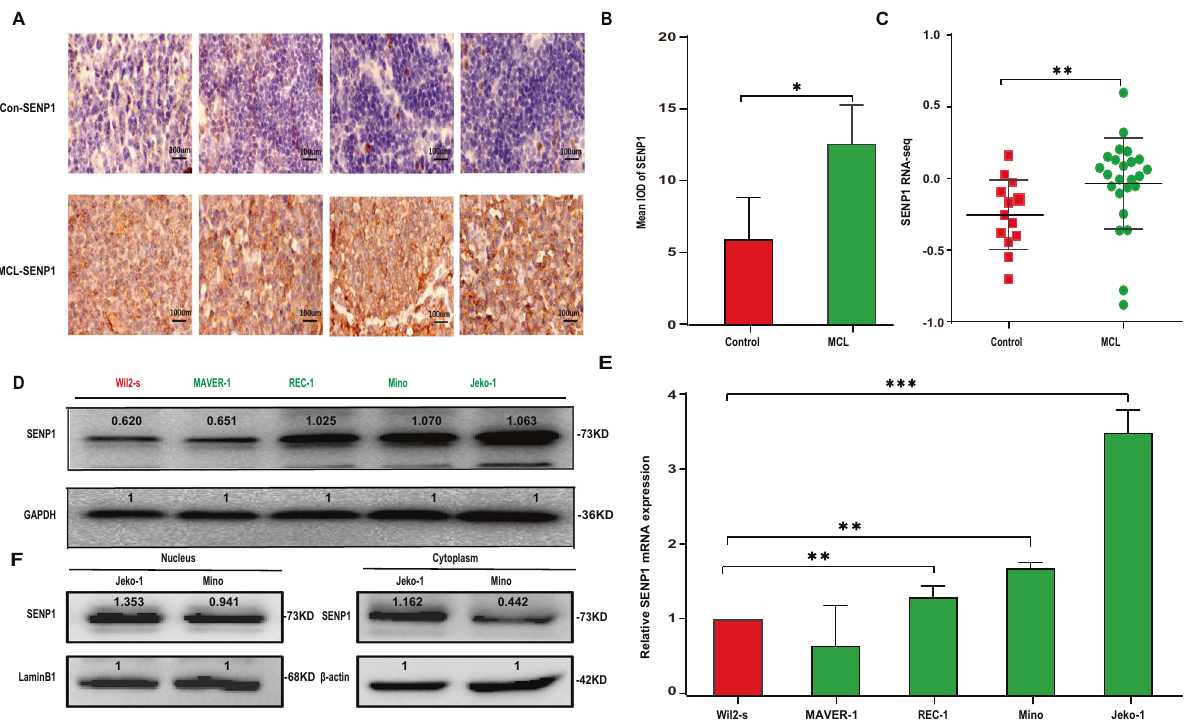
Fig. 1 SENP1 is highly expressed in human MCL samples and cell lines. A Representative immunohistochemical images of SENP1 staining in human MCL samples and control samples ( n = 4 per group). B The mean integrated optical density (IOD) of SENP1 protein in human MCL samples and control samples was calculated using Image-Pro Plus 6.0 software. C SENP1 mRNA level in human MCL samples and control samples was analyzed through extracting GEO RNA-seq data. SENP1 protein level was determined by western blot ( D ), SENP1 mRNA level was measured by RT-qPCR ( E ) in human normal B cell line (Wil2-s) and MCL cell lines (MAVER-1, REC-1, Mino and Jeko-1) . F Nuclear and cytoplasmic protein level of SENP1 was determined by western blot after subcellular fractionation in Jeko-1 and Mino cells. Data were presented as mean ± SD and analyzed by two-sided Student ’ s t test. n = 3; * P < 0.05, ** P < 0.01, and *** P <